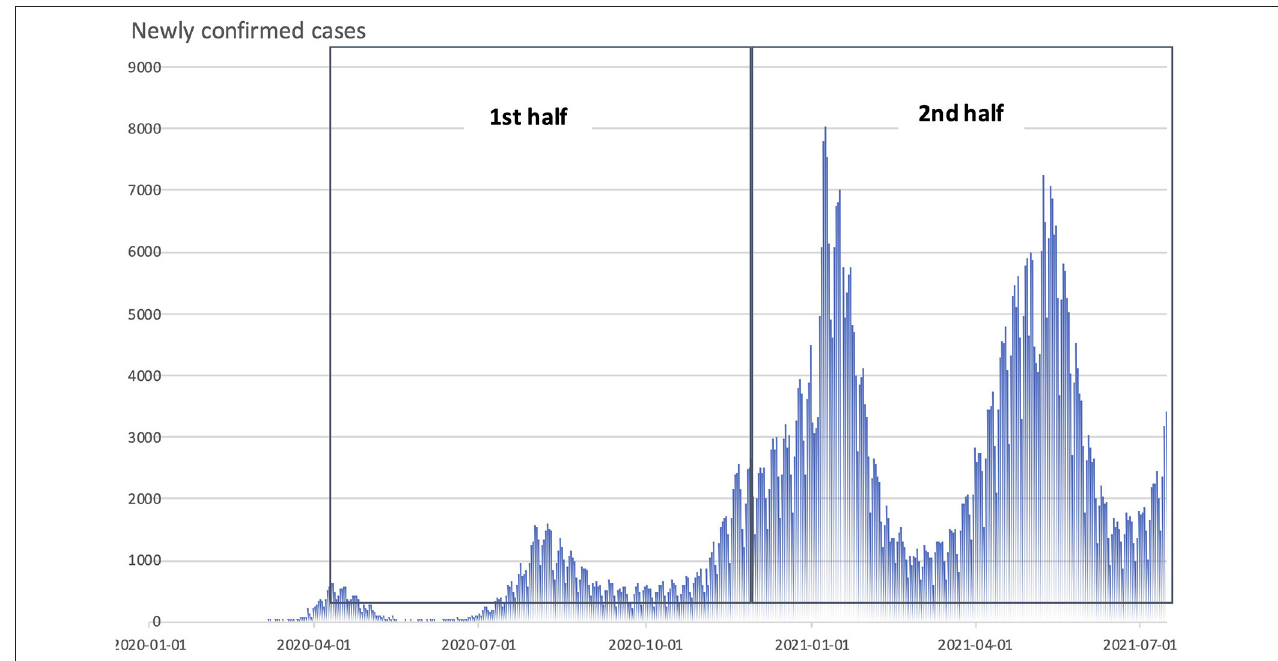
FIGURE 1 | Monthly trends in the number of new COVlD-19 infections in Japan and the period of the pandemic covered by this study (divided into first half and second halves: the first half was set at 7 ½ months, from April 2020 to mid-October 2020,and the second from then until the end of June 2021).